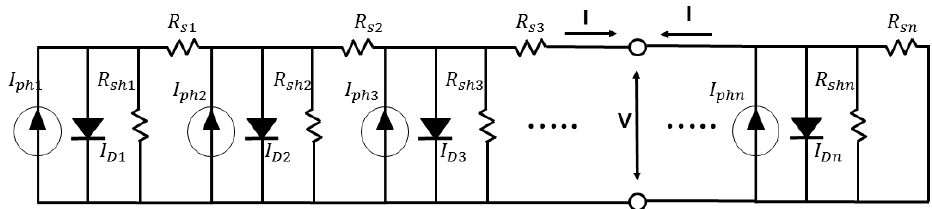
Figure 11. Equivalent circuit of small c-Si solar cells connected in parallel.